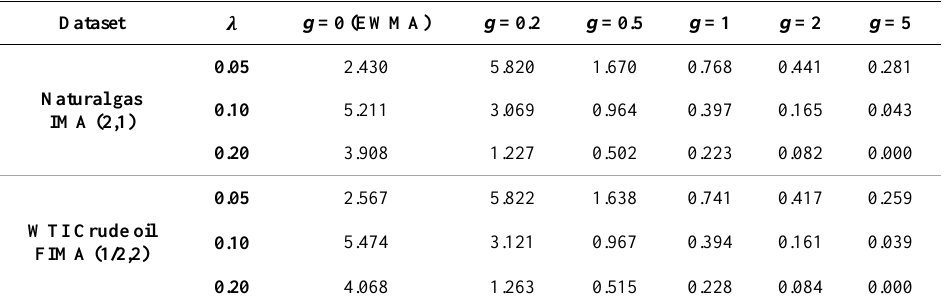
Table 8. Compare the RMI of two datasets at various g